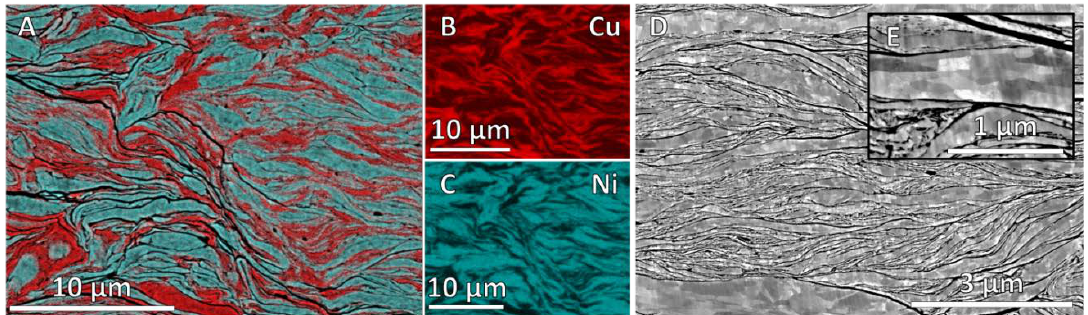
Figure 3. Ion-milled section of Ni 30 at % Cu milled for 20 min examined by ( A ) energy-dispersive X-ray spectroscopy (EDS) mapping to reveal that distinct areas of ( B ) Cu and ( C ) Ni are present; and ( D ) the grain structure is examined using backscatter electron (BSE) contrast with ( E ) high magnification inset.